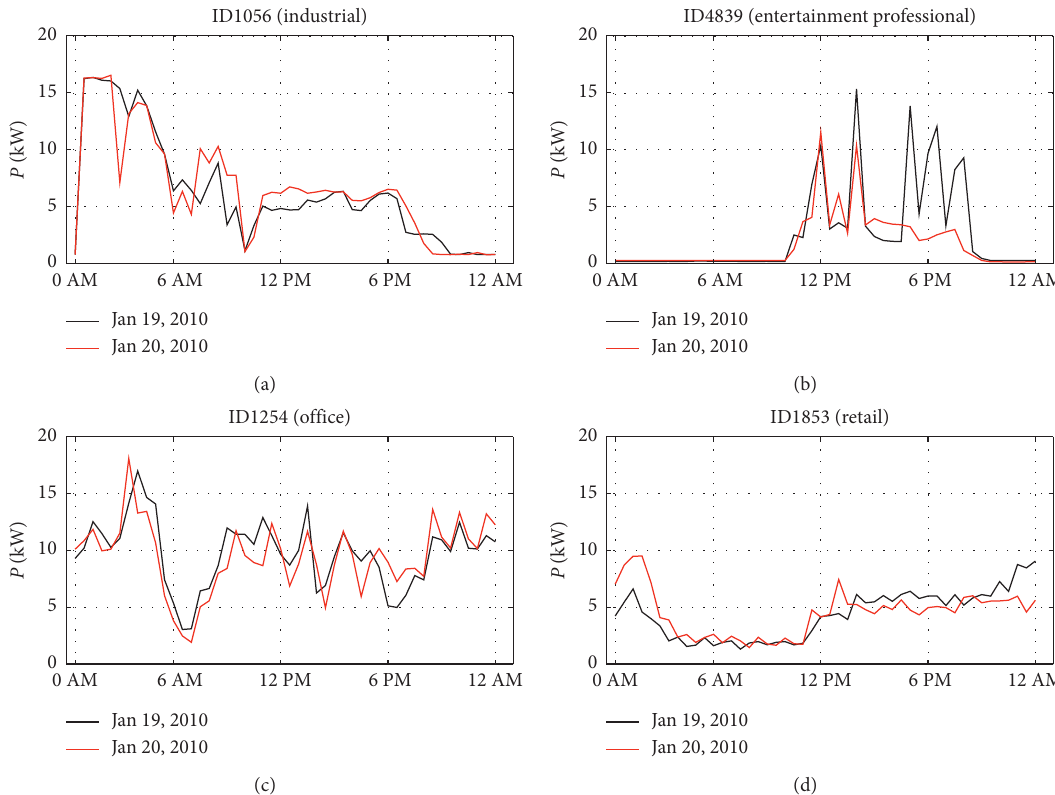
Figure 4: Power consumption of four SME loads in two consecutive working days.